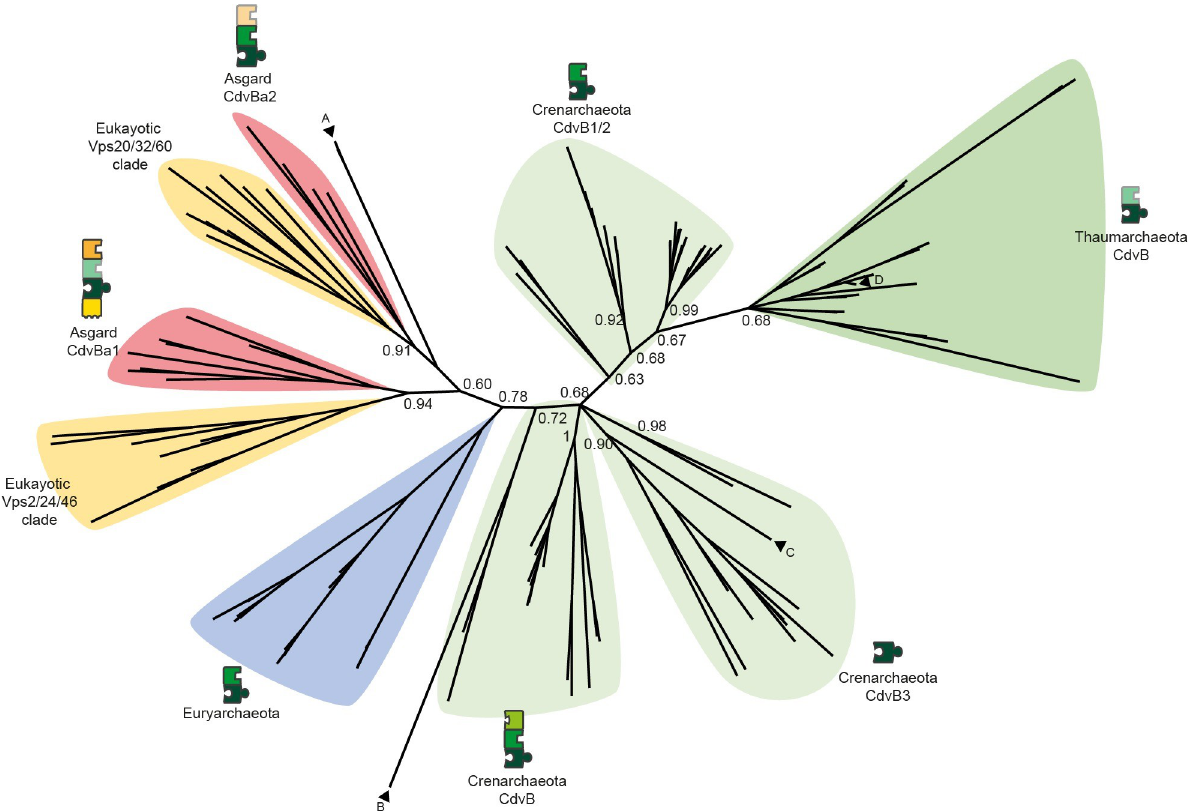
Fig 3. Phylogenetic tree of CdvB homologs calculated via Bayesian phylogeny. Background colours as in Fig 1 plus Eukaryotes (ESCRT-III proteins of Homo sapiens and Saccharomyces cerevisiae ) in yellow, proteins schematically depicted as sets of domains as in Fig 2. In Crenarchaeota, CdvB homologs split into three phylogenetic clusters (CdvB, CdvB1/2 and CdvB3) where within each cluster most homologs have the same domain composition. In Thaumarchaeota, no clear phylogenetic clustering is visible. In Asgard archaea, CdvB homologs split into two branches, with clear differences in domain architecture between clusters. They group together with the two eukaryotic ESCRT-III groups Vps2/24/46 (CdvBa1) and Vps20/32/60 (CdvBa2), indicating a shared evolutionary history of ESCRT-III proteins in Asgard archaea and Eukaryotes. Single proteins that do not match the clusters are indicated by arrows. These might be the results of horizontal gene transfer or contamination of metagenome data. A: Two Euryarchaeota CdvB proteins ( Thermoplasa acidophilum , UniProt ID Q9HIZ5 and Thermoplasma volcanium , Q97BR8). B: